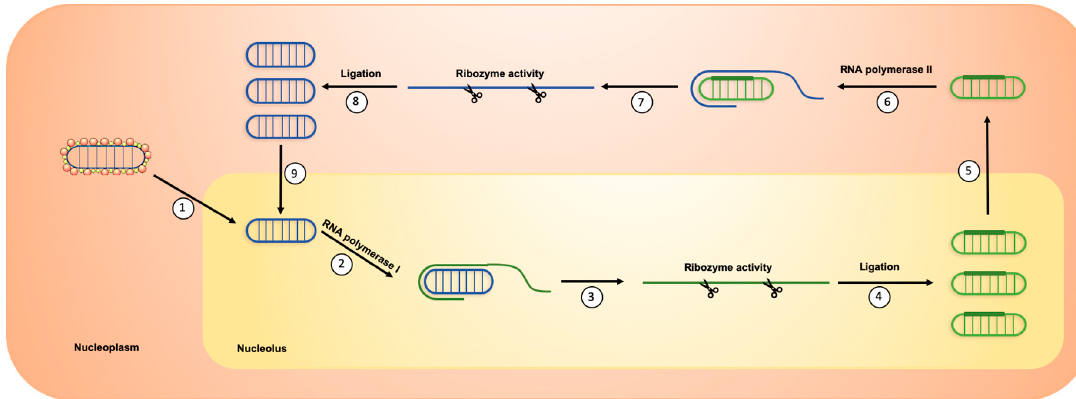
Figure 3. HDV replication. (1) HDV genome is translocated in the nucleolus. (2) It is then recognized by RNA polymerase I to produce concatemers of linear antigenomic RNAs through a rolling circle mechanism. (3) Ribozyme activity induced the cleavage of antigenomic RNA concatemers in antigenomic RNA monomers. (4) Linear antigenomic RNAs are circularized through an unknown ligation process. (5) Antigenomic RNAs are translocated in the nucleoplasm. (6) They are then recognized by RNA polymerase II to produce concatemers of linear genomic RNAs through a rolling circle mechanism. (7) Ribozyme activity induces the cleavage of genomic RNA concatemers into linear genomic RNA monomers. (8) Linear genomic RNAs are then circularized through an unknown ligation process. (9) Newly synthesized HDV genomic RNAs can be translocated again in the nucleolus for a new round of replication.